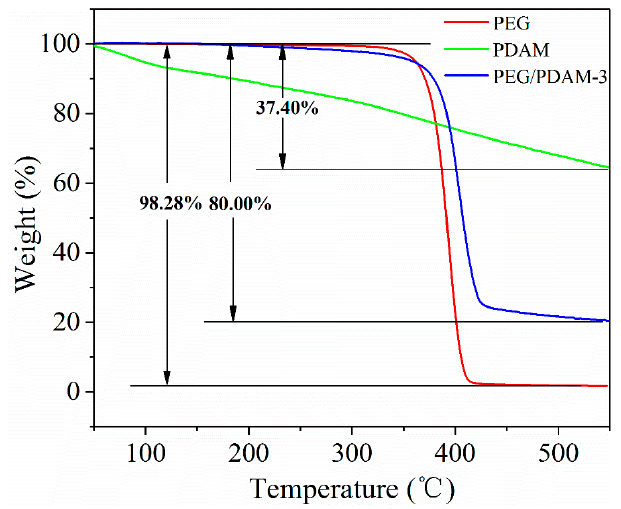
Figure 11. TGA curves of PEG, PDAMs, and PEG/PDAM-3.